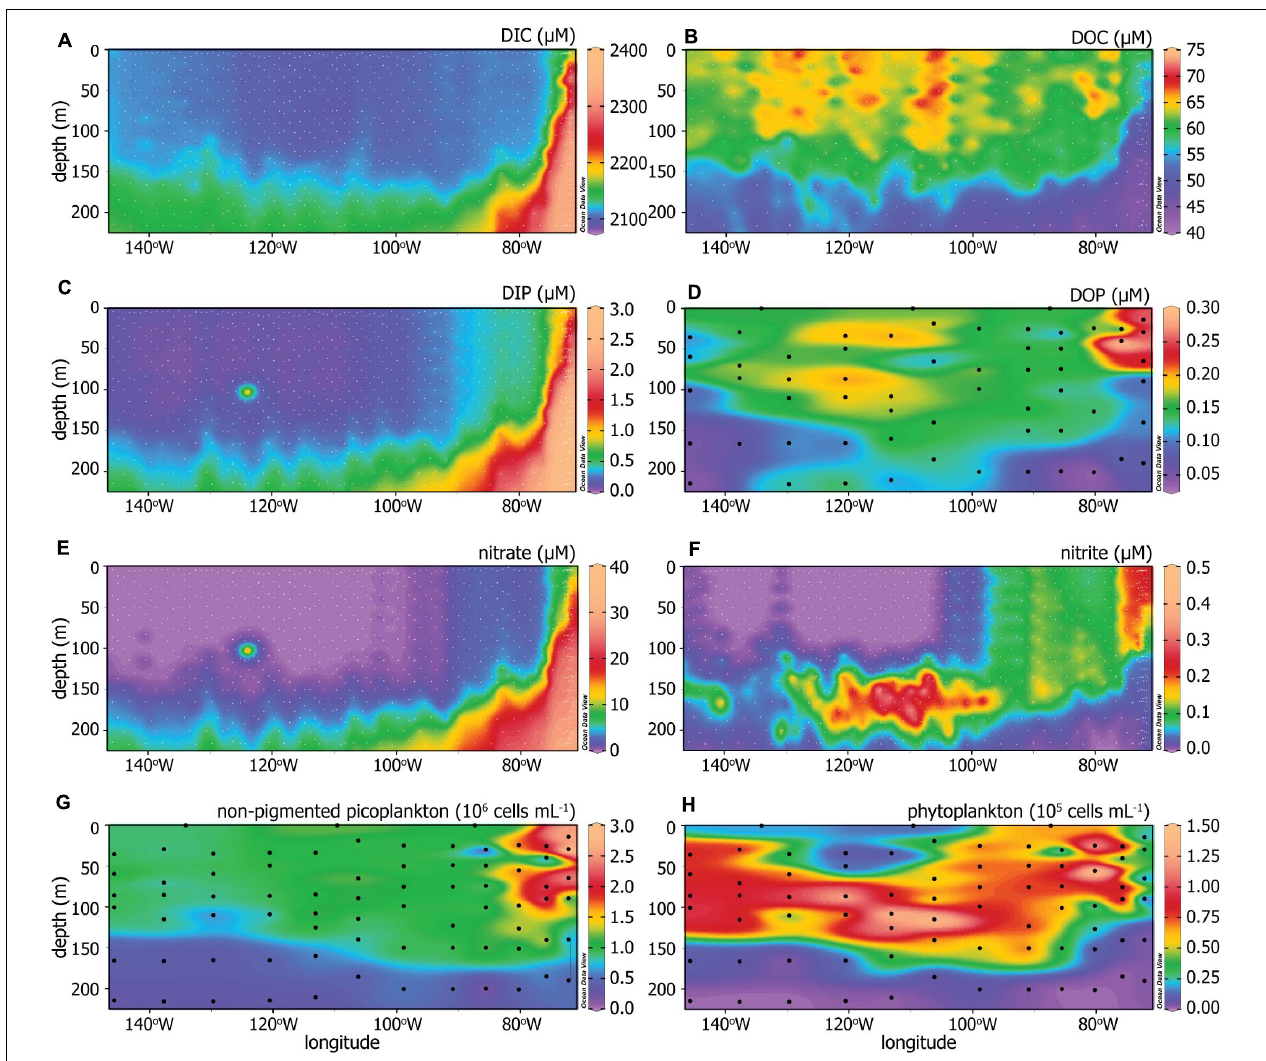
FIGURE 3 | (A) Dissolved inorganic carbon (DIC), (B) dissolved organic carbon (DOC), (C) dissolved inorganic phosphorus (DIP), (D) dissolved organic phosphorus (DOP), (E) nitrate, (F) nitrite, (G) non-pigmented picoplankton abundance, and (H) phytoplankton abundance across the P06E transect. The dots indicate sampling depths and locations, where white dots indicate sampling done by other members of the U.S. GO-SHIP P06 cruise (Swift et al., 2019) and black dots are sampling completed in this